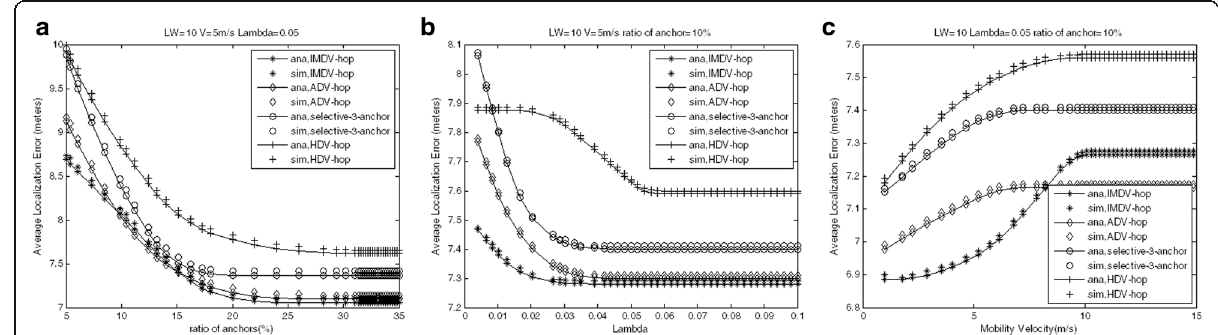
Fig. 10 Localization error comparisons. a Localization error comparisons for different schemes based on the ratio of anchors. b Localization error comparisons for different schemes based on node density. c Localization error comparisons for different schemes based on mobility velocity